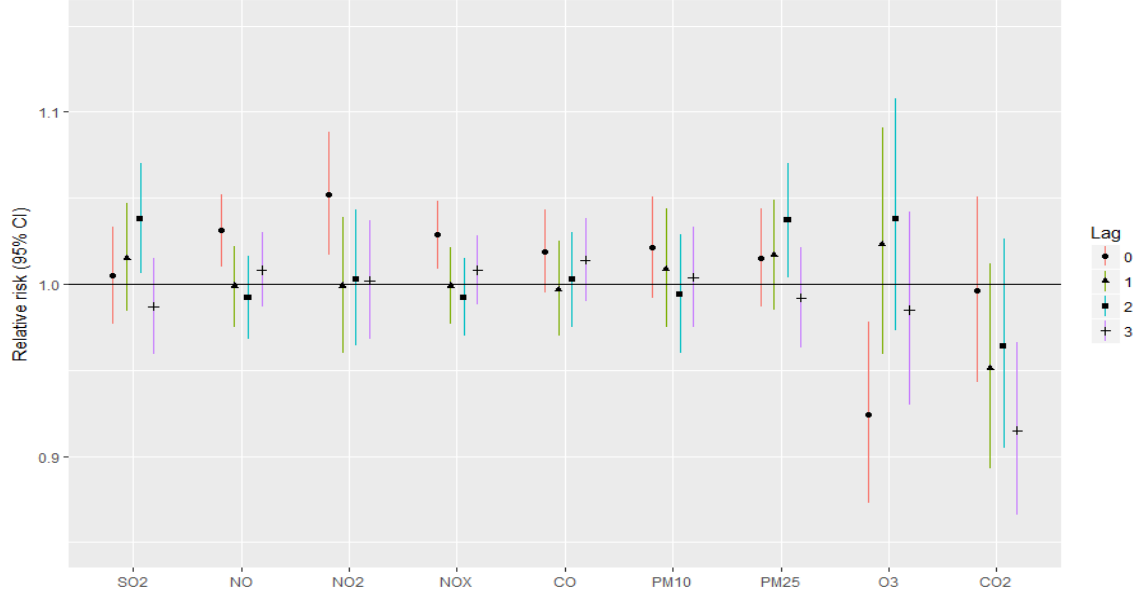
Figure 2. Relative risk of myocardial infarction for IQR changes in air pollutant levels for different lags in single-pollutant models.